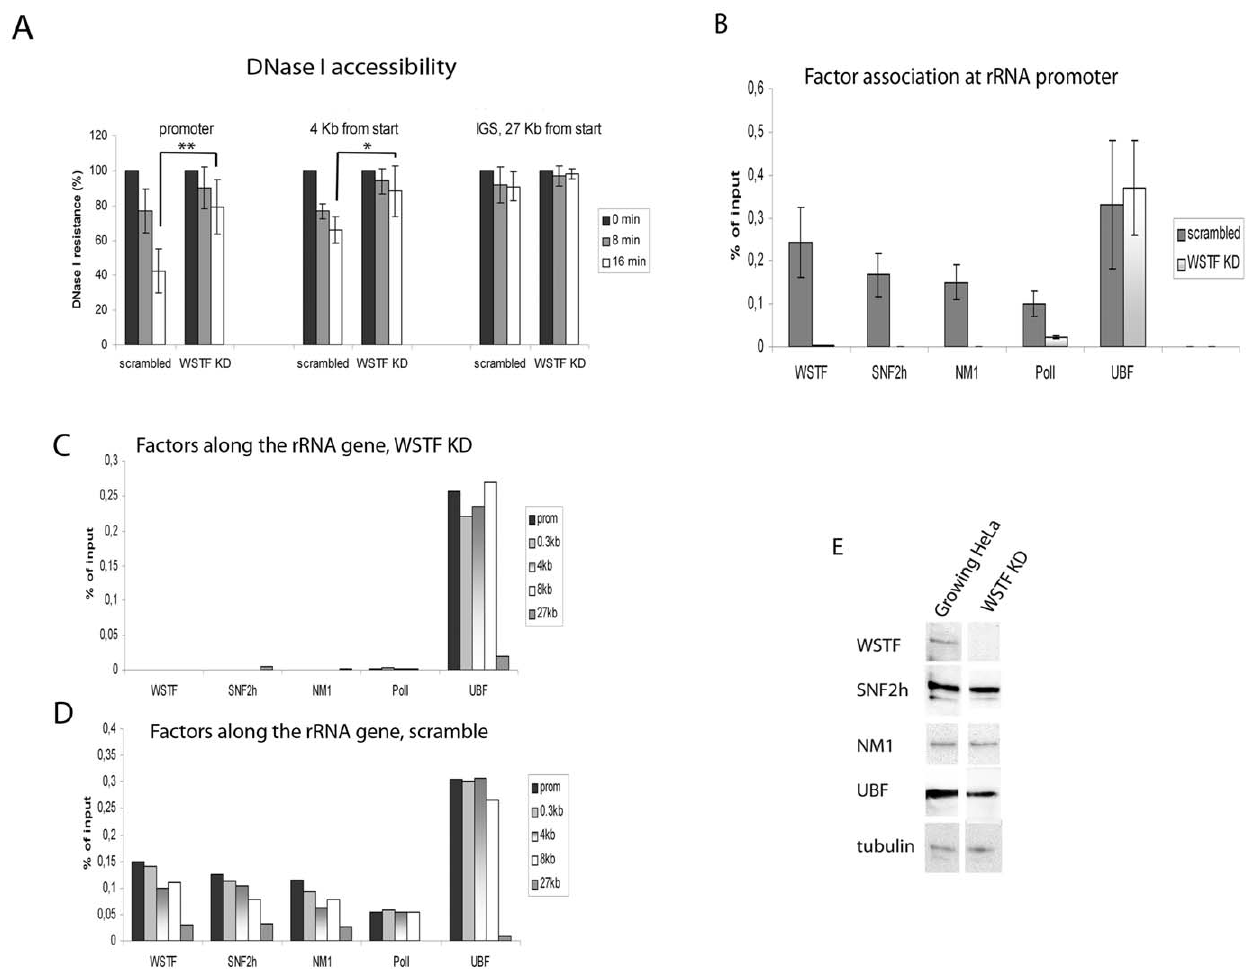
Figure 2. WSTF alters the chromatin structure at the rDNA and changes factor access to DNA. ( A ) DNAse digestion of cells for the times indicated, before preparing DNA and amplifying regions at the rRNA promoter, 4 kb into the gene, and in the IGS (at position 27 kb from transcription start site) with specific PCR primer pairs. The signal intensities of the products were quantified using Quantity One, Bio-RAD. Error bars represent standard deviation **: p-value of 0.0007, *: p-value of 0.04 (Student t-test, paired, n=4). ( B ) ChIP of WSTF KD cells and cells transfected with scrambled control SiRNA using primers over the rRNA promoter to detect DNA precipitated by the antibodies indicated below the bars. The values are presented as the percentage of the input signal for each primer pair. Error bars represent standard deviations from four separate experiments. ( C ) ChIP of WSTF KD cells using PCR primers which detected the position along the rDNA repeat as indicated with the antibodies as indicated below the bars. The signals are the percentages of the input signal for each primer pair. One representative experiment of four. ( D ) ChIP of cells transfected with scrambled control SiRNA using PCR primers which detected the position along the rDNA repeat as indicated with the antibodies as indicated below the bars. The signals are the percentages of the input signal for each primer pair. One representative experiment of four. ( E ) Immunoblots (7% SDS- PAGE) of proteins from cell lysates from growing HeLa cells and WSTF KD cells probed with the antibodies indicated at the left.